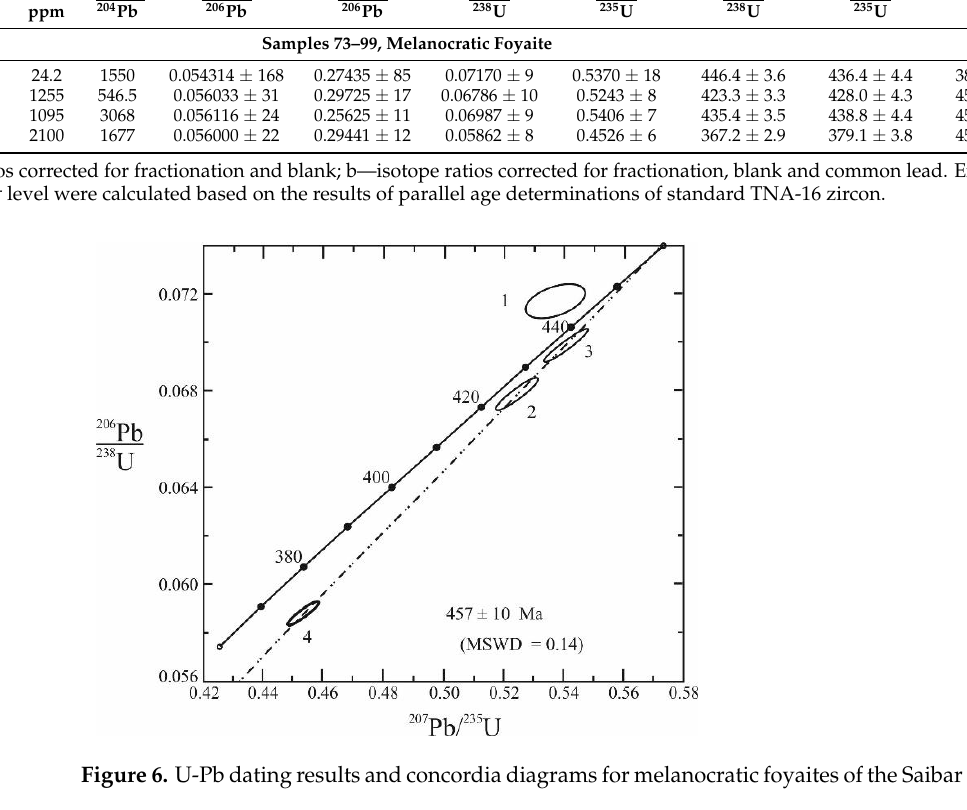
Table 2. Chemical composition of the Saibar rocks.